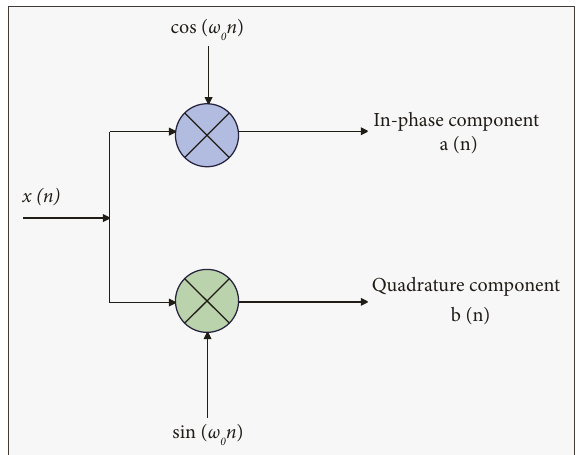
Figure 7: Digital quadrature